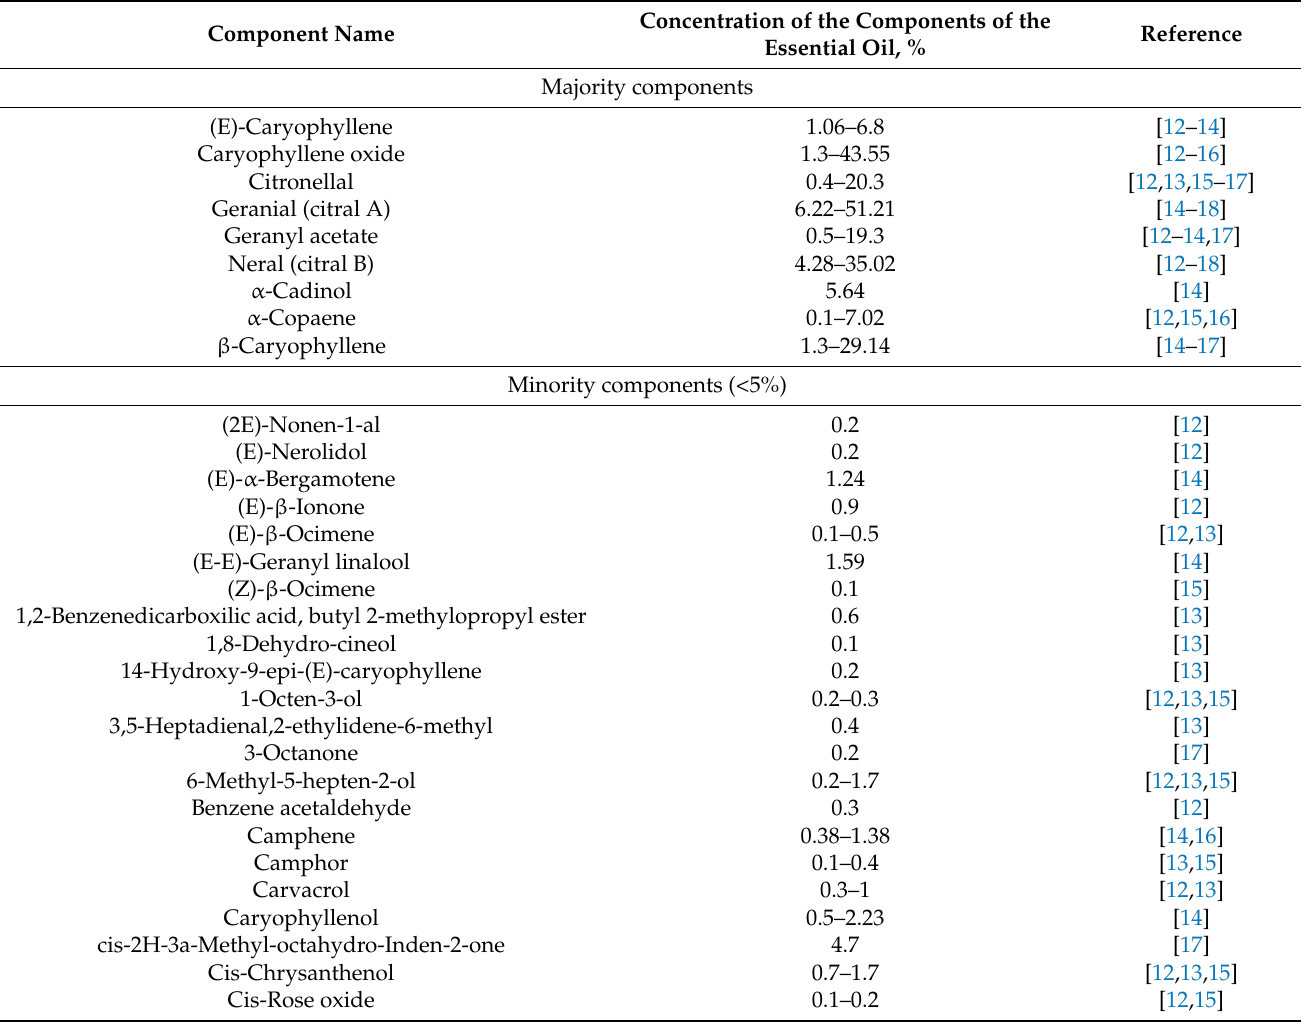
Table 1. Components of the essential oil extracted from the dried leaves of Melissa officinalis